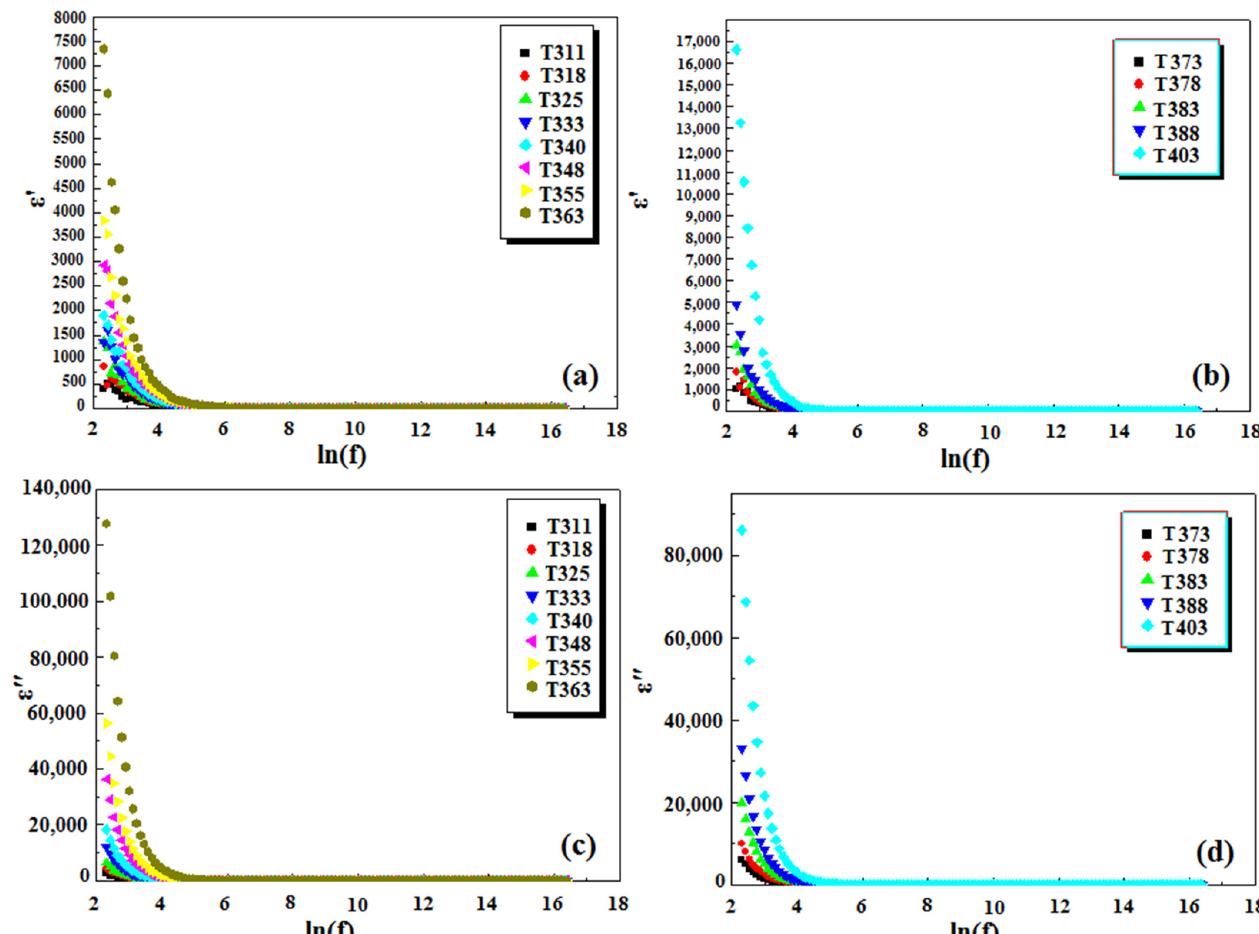
Figure 12. ( a , b ) ε ’ as a function of ln(f); ( c , d ) ε″ as function of ln(f).